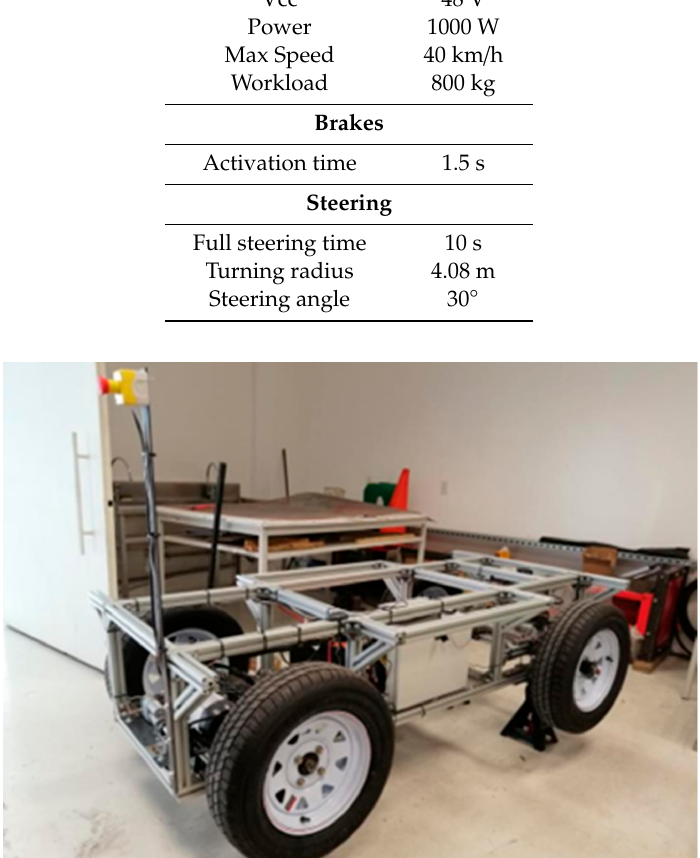
Figure 3. Modular platform built by Campus Puebla.